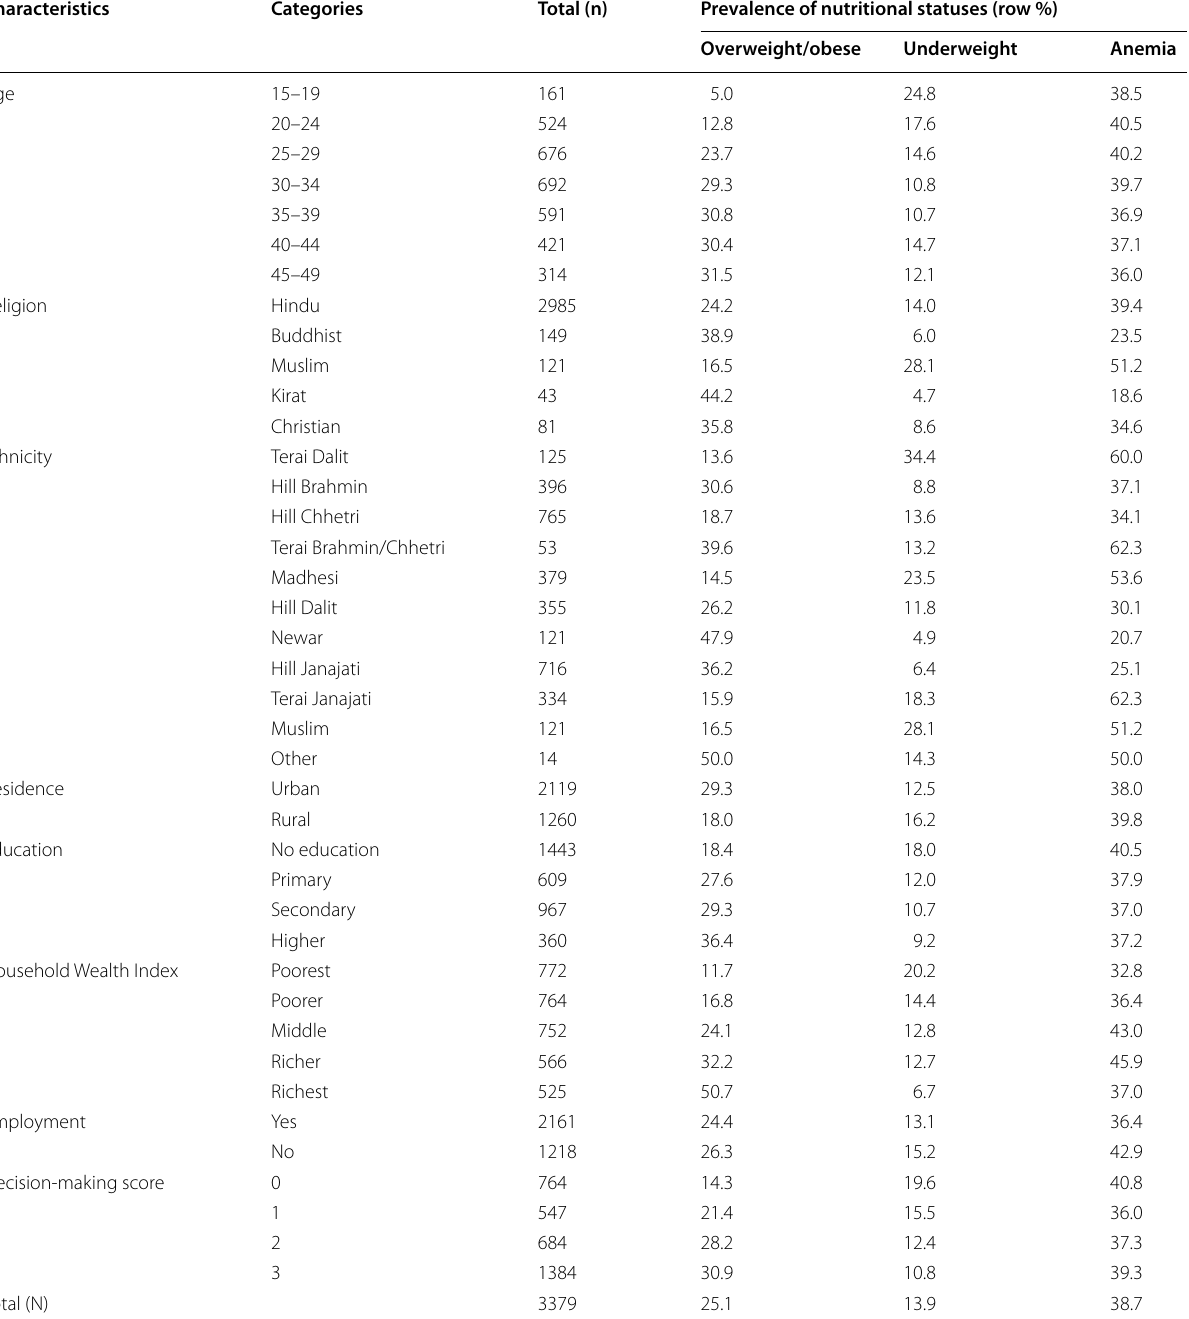
Table 1 Prevalence of BMI statuses and anemia across sociodemographic characteristics